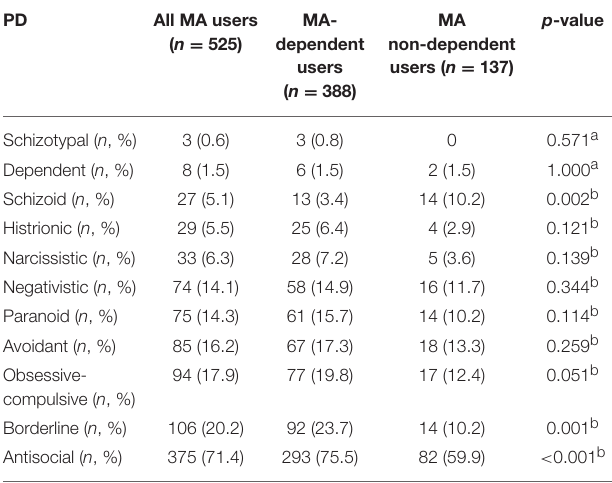
TABLE 3 | Prevalence rates of personality disorders (PDs) of the study sample and group comparison between methamphetamine (MA)-dependent and non-dependent